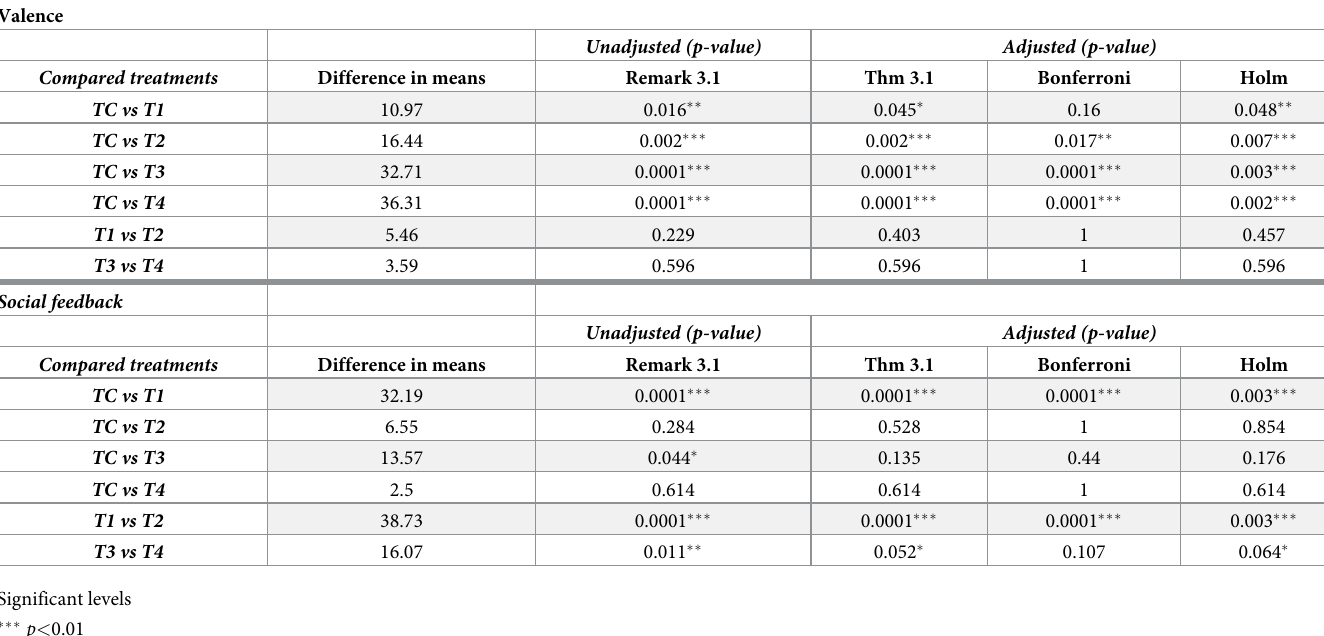
Table 4. Multiple hypothesis testing (MHT) of changes in emotional states (comparison between the control and emotion treatments and between positive and neg- ative emotions). Valence Unadjusted (p-value) Adjusted (p-value) Compared treatments Difference in means Remark